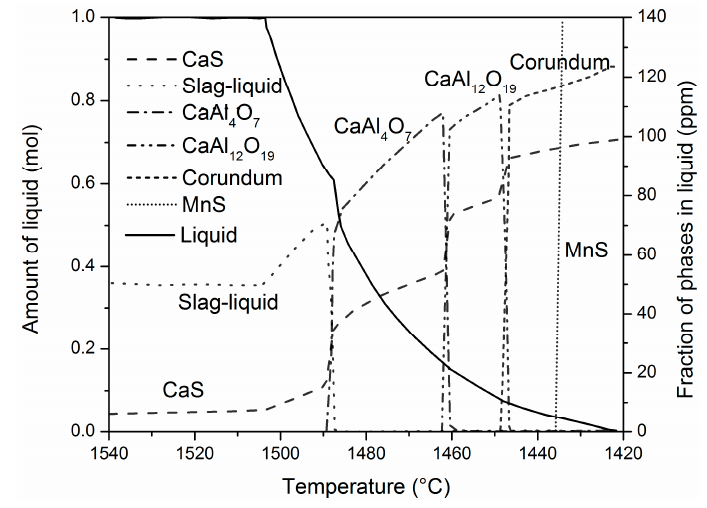
Figure 6. Formation of inclusions during cooling and solidification in high-carbon steel [100].